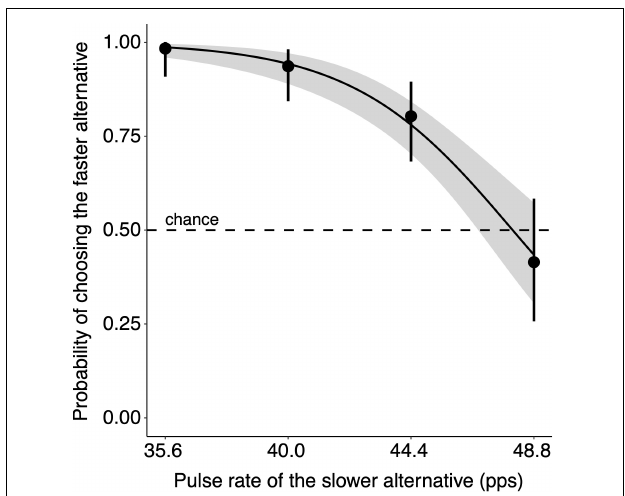
FIGURE 2 | Pulse rate preference function in quiet conditions and the absence of inconsistency (CV w = 0). Subjects chose between a stimulus whose nominal mean pulse rate was equal to the population mean (0 SD = 48.8 pps) and a stimulus whose nominal mean pulse rate was 0, 1, 2, or 3 SD slower (48.8, 44.4, 40.0, or 35.6 pps, respectively). The proportion choosing the faster realized mean pulse rate declined as the two alternative pulse rates became more similar. Individual points show the proportion of tests in which subjects chose the faster stimulus calculated across all tests with the same nominal mean pulse rate. The solid black line shows the logistic regression line of best fit with gray shading illustrating standard error. The dashed line shows 0.5, or the probability of choosing the stimulus with the faster pulse rate by chance. The error bars show 95% Clopper–Pearson (“exact binomial”) confidence